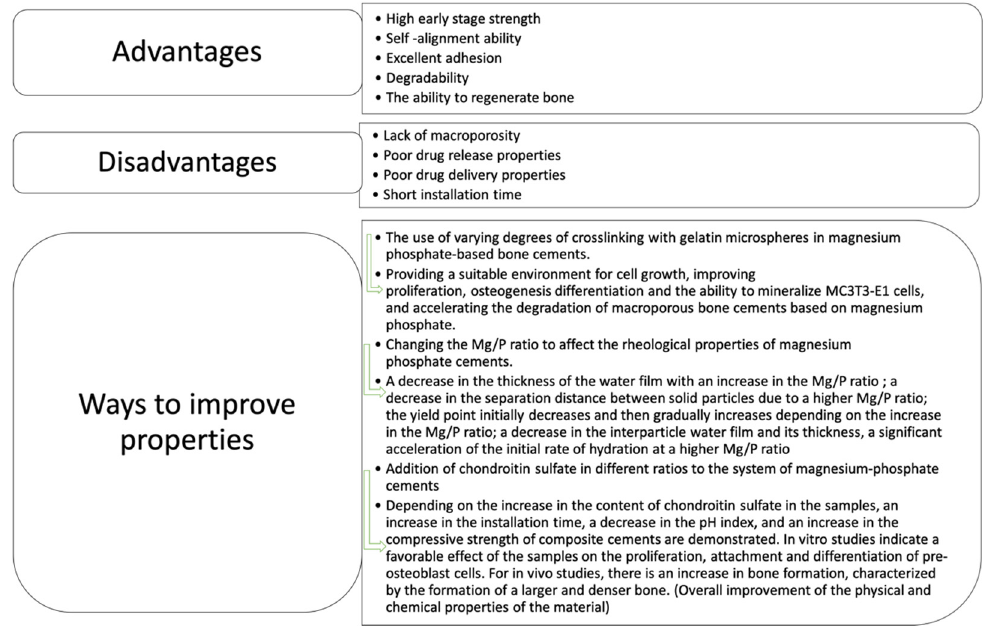
Figure 3. Highlights of the main advantages, disadvantages, and ways of affecting the properties of magnesium phosphate cements, as well as the results of these manipulations.